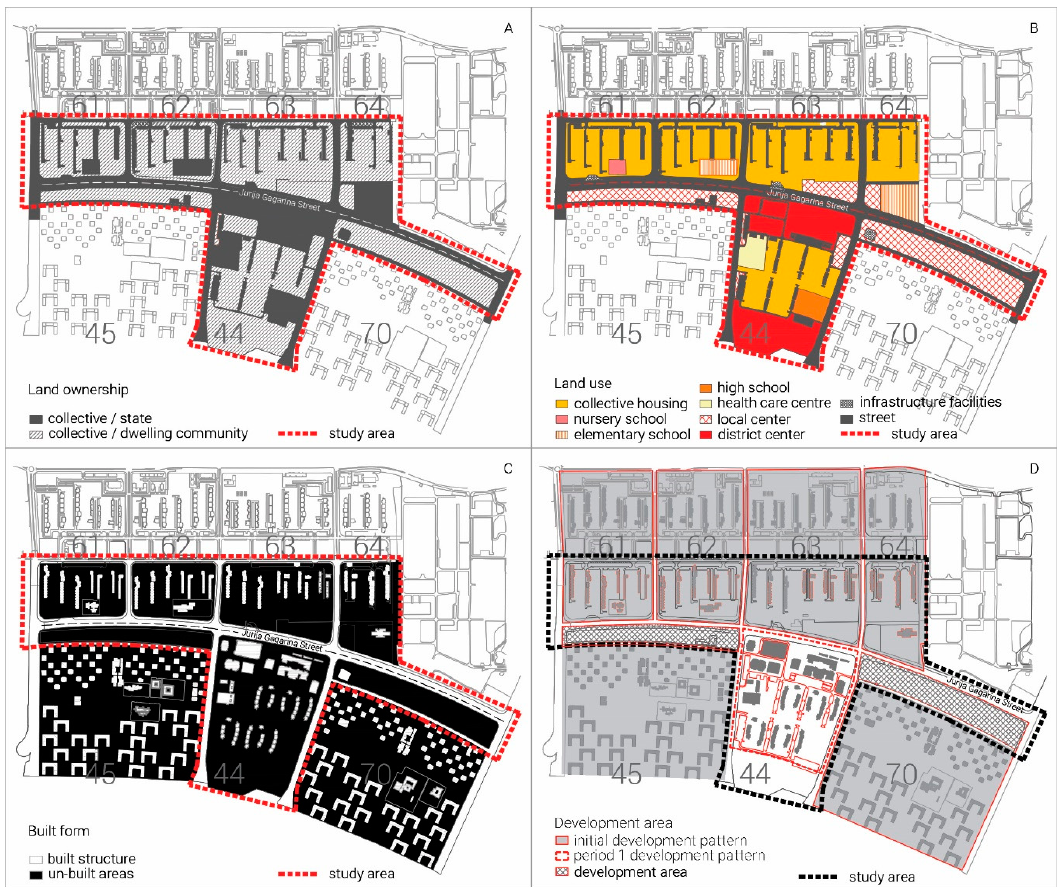
Figure 4. Morphogenesis of Jurija Gagarina Street, period 1: ( A ) Land ownership, ( B ) land-use, ( C ) built form, and ( D ) pattern of growth (source: authors).